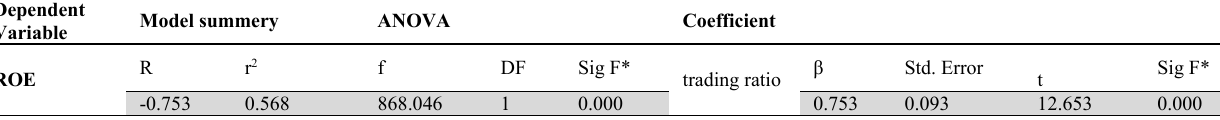
Simple regression test results, the effect of trading ratios at return on equity Dependent Model summery ANOVA Variable